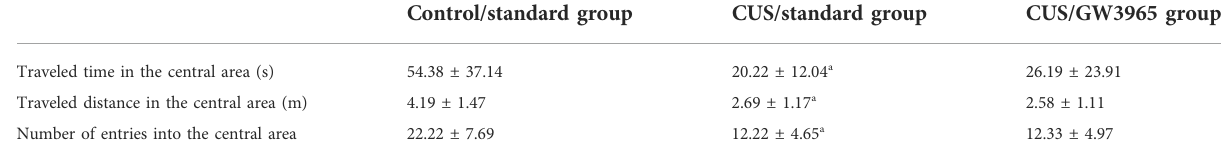
TABLE 2 Comparisons of the OFT results among the Control/standard group, the CUS/standard group and the CUS/standard GW3965 group after GW3965